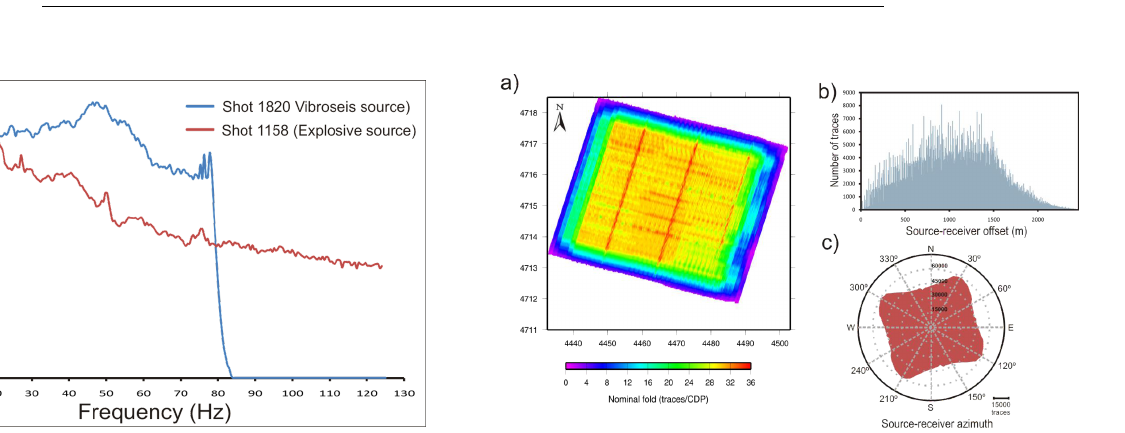
FIG. 4: Frequency spectra of the shot gathers shown in FIG. 3: shot gather 1820, Fig. 4. Frequency spectra of the shot gathers shown in Fig. 3: shot acquired with Vibroseis source (dark grey) and shot gather 1158, acquired with gather 1820, acquired with Vibroseis source (dark grey) and shot explosive source (light grey). gather 1158, acquired with explosive source (light grey). The high- cut filter in the spectrum of the Vibroseis data was applied in the field.